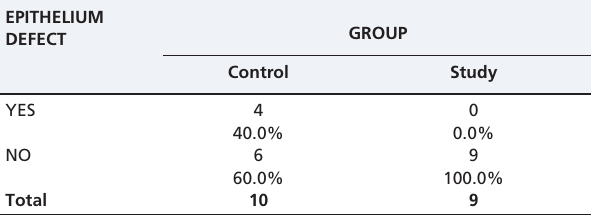
Table 7 - Comparative analysis among the groups regarding the epithelial integrity 14 days after the chemical burn.